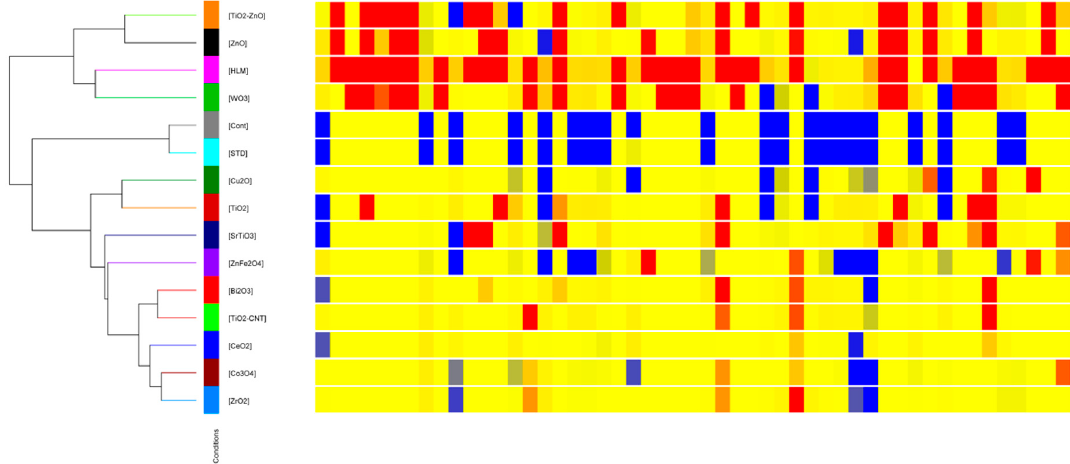
Figure 2. Cluster dendrogram and heatmap of the standard sample (STD), Control (Cont), HLM after 120 min of incubation and photocatalytic experiments samples after 60 min of irradiation.